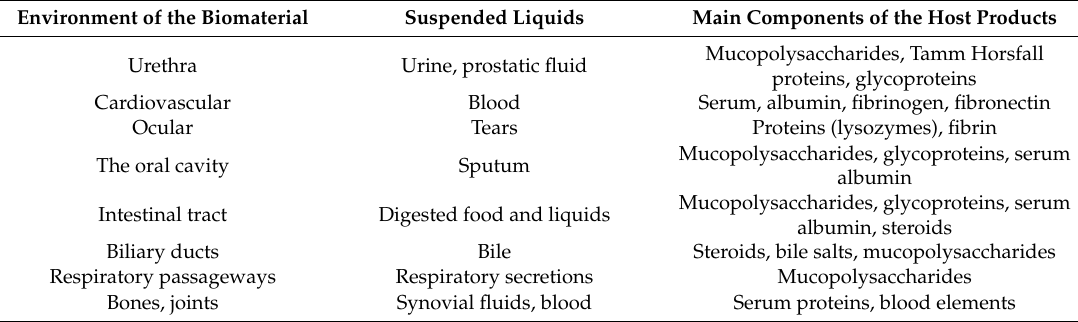
Table 1. Host products a ff ecting bacterial attachment to a biomaterial